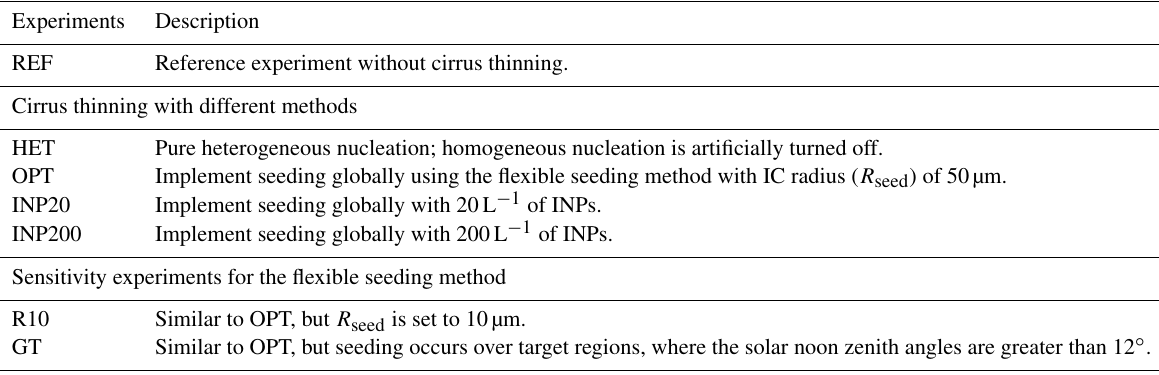
Figure 1. Schematic diagram of different seeding methods, reference results without seeding (REF, black), pure heterogeneous nucleation (HET, green), seeding with the optimal number concentration of ICs (OPT, red), seeding with 20L − 1 of INPs (INP20, blue), and seeding with 200L − 1 of INPs (INP200, orange). The optimal seeding method uses ICs with the radius of 25µm. Panel (a) shows simulation results from the parcel model with given initial conditions ( P = 330hPa, T = 220K, W = 0 . 3ms − 1 , N dust = 10L − 1 , and N sul = 500000L − 1 ). The solid lines denote the total number concentrations of ICs in the parcel ( N i , units: L − 1 ), which include the seeding ICs and the newly formed ICs, and the dashed lines denote ice supersaturation ( S i , units: %). The arrows point to the beginning of homogeneous nucleation. Panel (b) shows the N i from ice nucleation parameterizations driven by the same 1000 datasets of input variables (one dot denotes one offline result), which are sampled from the CAM5 simulation. The horizontal coordinate axis is N i , and the vertical coordinate axis is meaningless. Table 1. List of CAM5